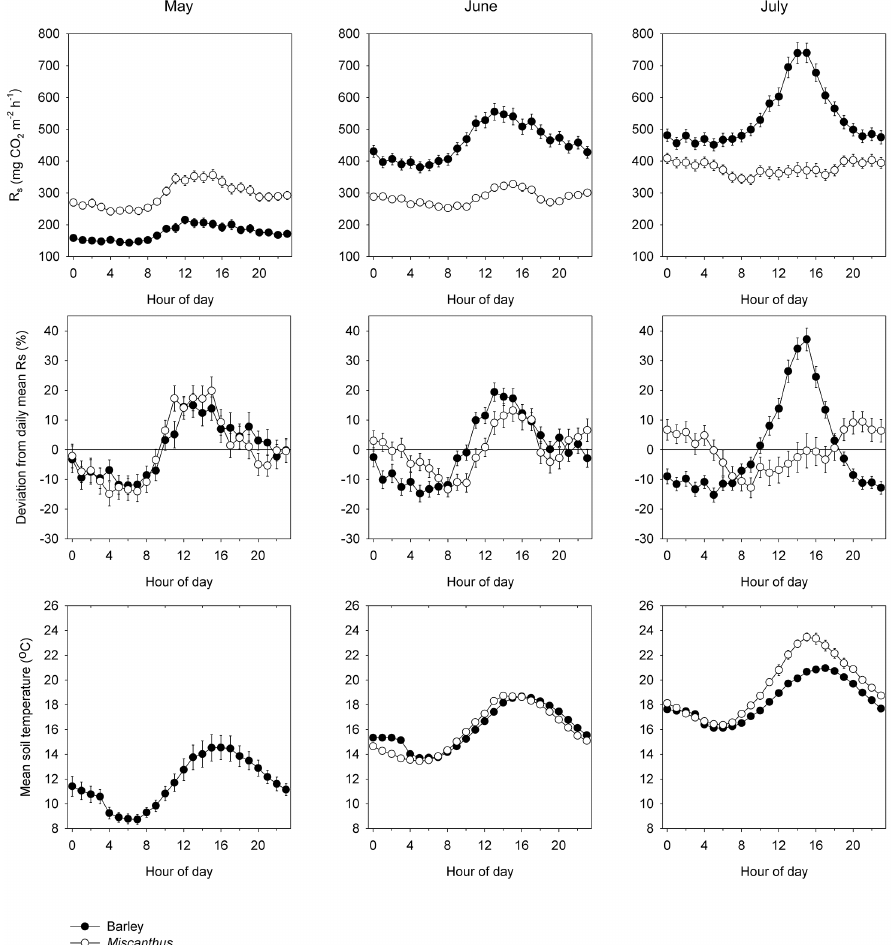
Figure 2. The diurnal pattern of R s and soil temperature at 5cm depth for each month of the study for barley and Miscanthus crops. Values shown are mean ( ± 1SE) average hourly absolute values of flux R s (top row) and deviation from the daily mean (middle row). The shaded area of the middle panels represents the typical measurement window during which manual sampling would take place. Zero deviation represents the daily mean flux, positive deviation representing fluxes greater than the mean and negative fluxes smaller than the